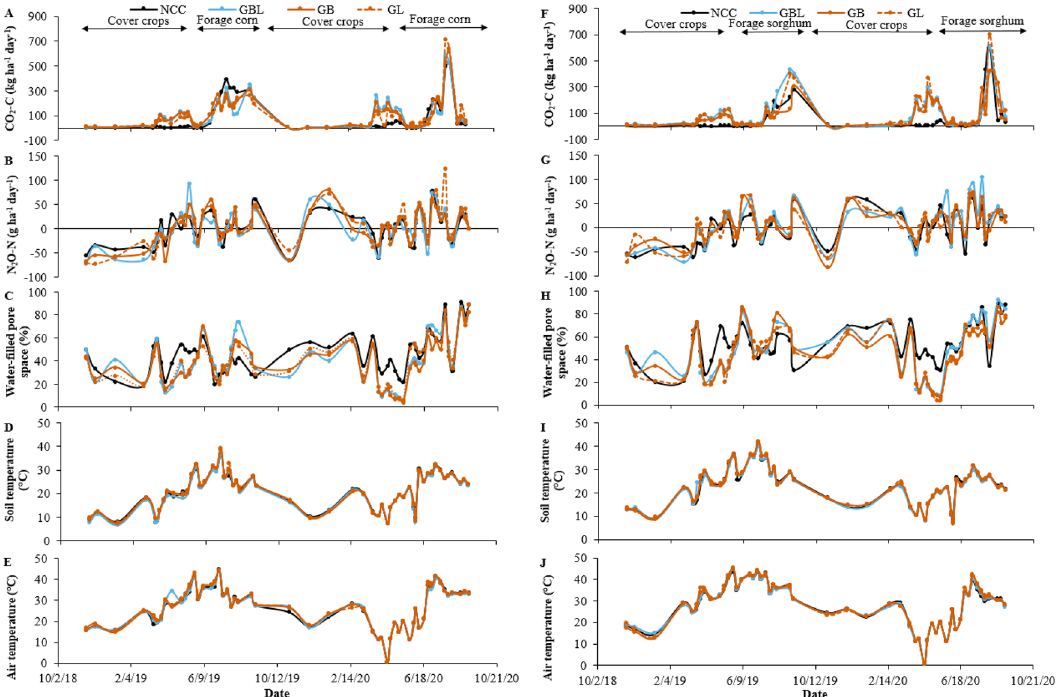
Figure 1. Trend of average CO 2 and N 2 O emissions, water-filled pore space, soil temperature, and air temperature under cover crop treatments during forage corn and sorghum production from 2018 to 2020. ( A ) Average CO 2 -C emission (kg ha −1 day −1 ), ( B ) average N 2 O-N emission (g ha −1 day −1 , ( C ) water-filled pore space (%), ( D ) soil temperature (°C), and ( E ) air temperature (°C) in cover crop-corn rotation, and ( F ) average CO 2 -C emission, ( G ) average N 2 O-N emission, ( H ) water-filled pore space (%), ( I ) soil temperature (°C), and ( J ) air temperature (°C) in cover crop-sorghum rotation. NCC no cover crops control, GBL grasses, brassicas, and legumes mixture, GB grasses and brassicas mixture, GL grasses and legumes mixture.